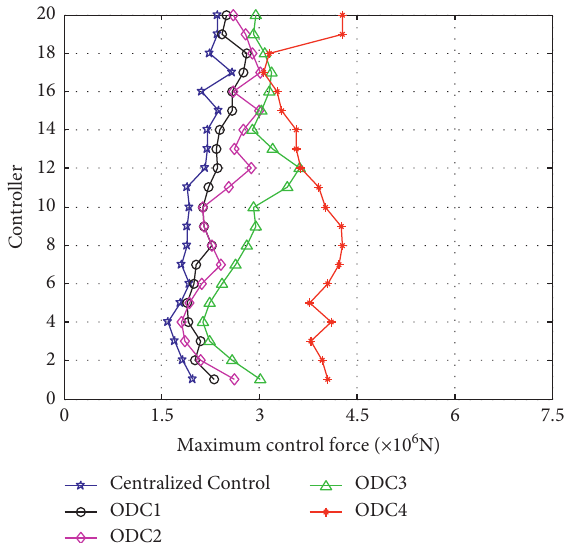
Figure 11: The maximum control force of time delay τ � 40ms.